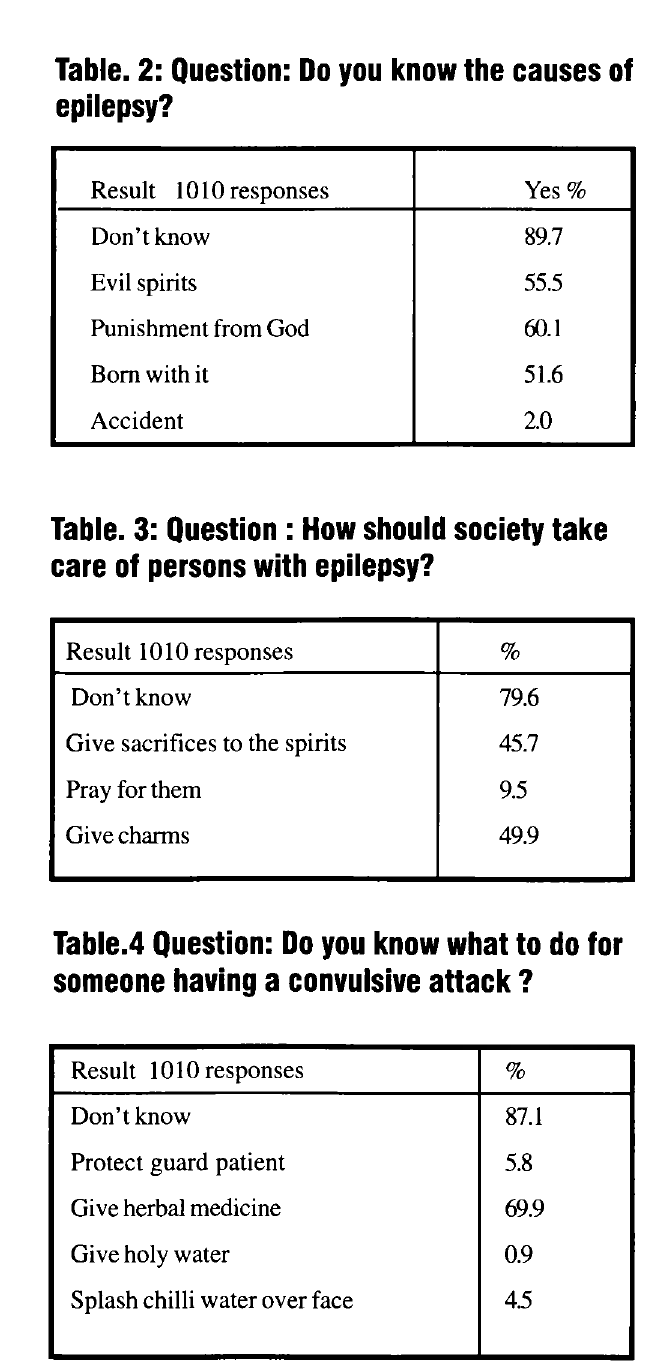
Table. 2: Question: Do you know the causes of epilepsy?